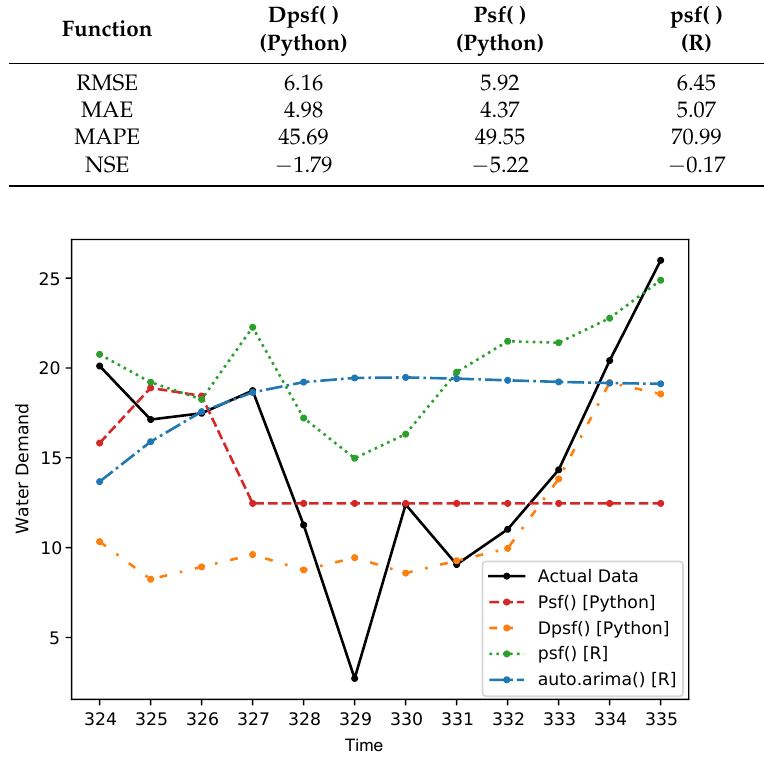
Figure 9. Plot showing the test data and values forecasted using various methods for the “Water Demand”